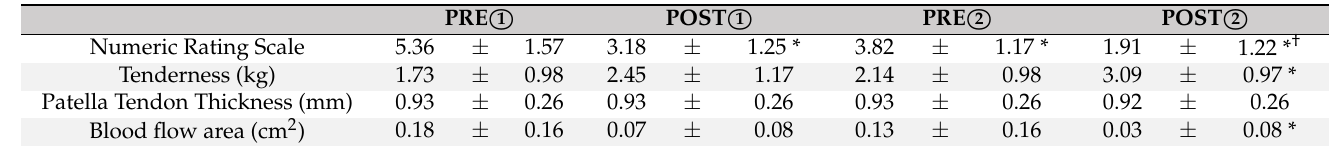
Table 1. Evaluation item.